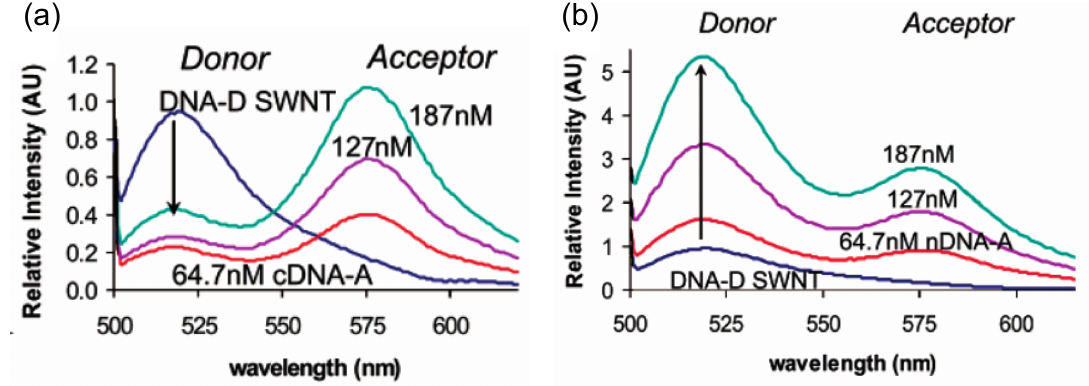
Figure 5. Intensity at donor emission (max 520 nm) of DNA-D-NT. ( a ) Förster resonance energy transfer (FRET) is clearly occurring, as indicated by the two alternating